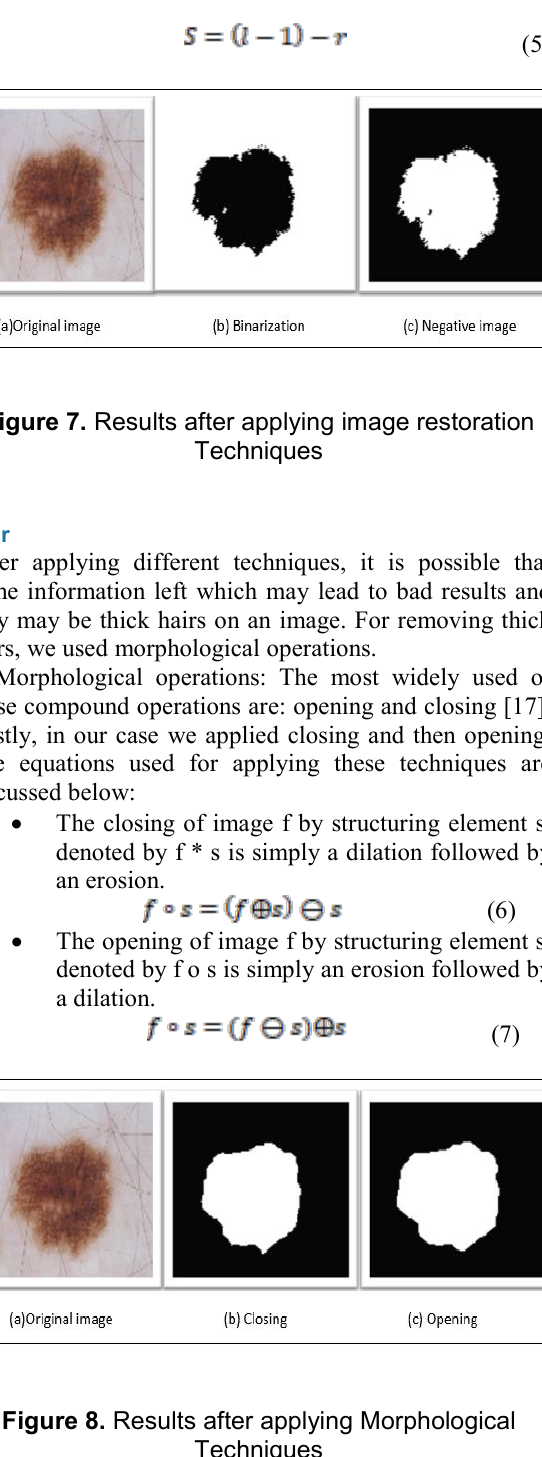
Figure 8. Results after applying Morphological